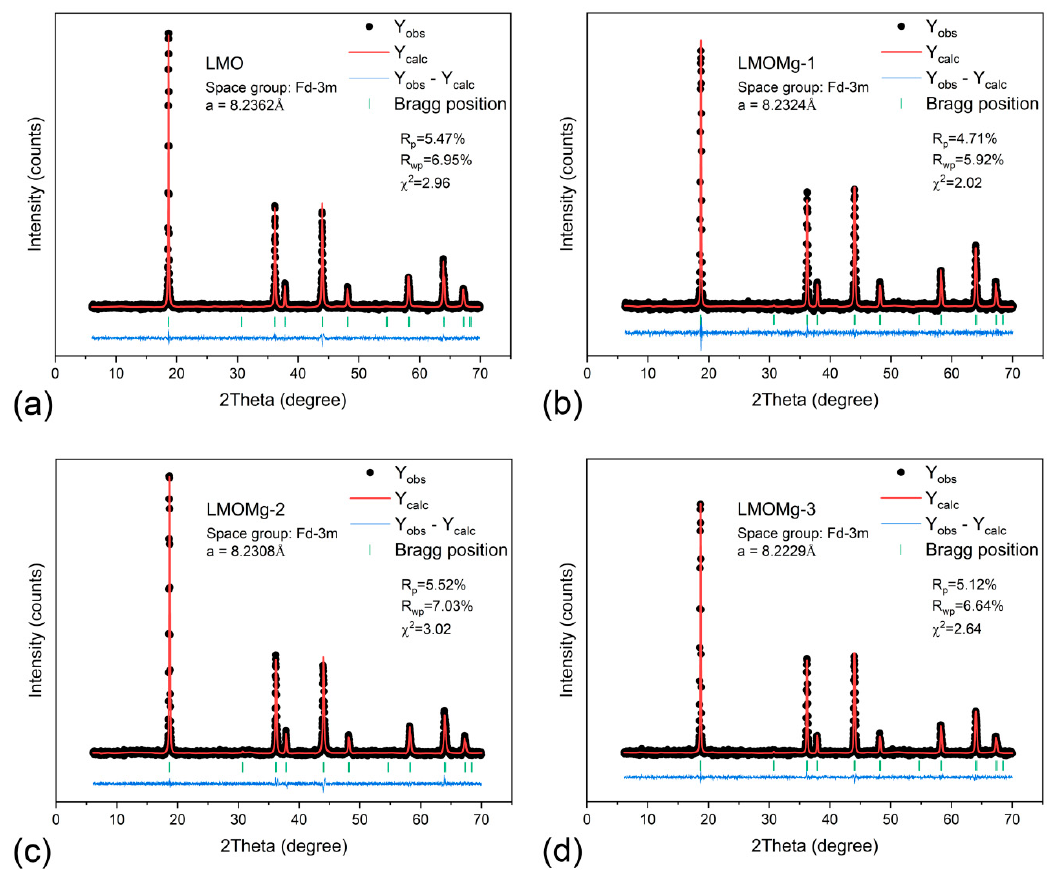
Figure 7. Rietveld refinement results of powder X-ray diffraction (XRD) data from magnesium-doped manganese spinels: ( a ) LMO, ( b ) LMOMg-1, ( c ) LMOMg-2, and ( d ) LMOMg-3. Data points are shown as black dots. The calculated pattern is shown with a solid red line. Vertical green bars show Bragg peak positions. A blue line at the bottom shows the difference between data and calculated intensities.